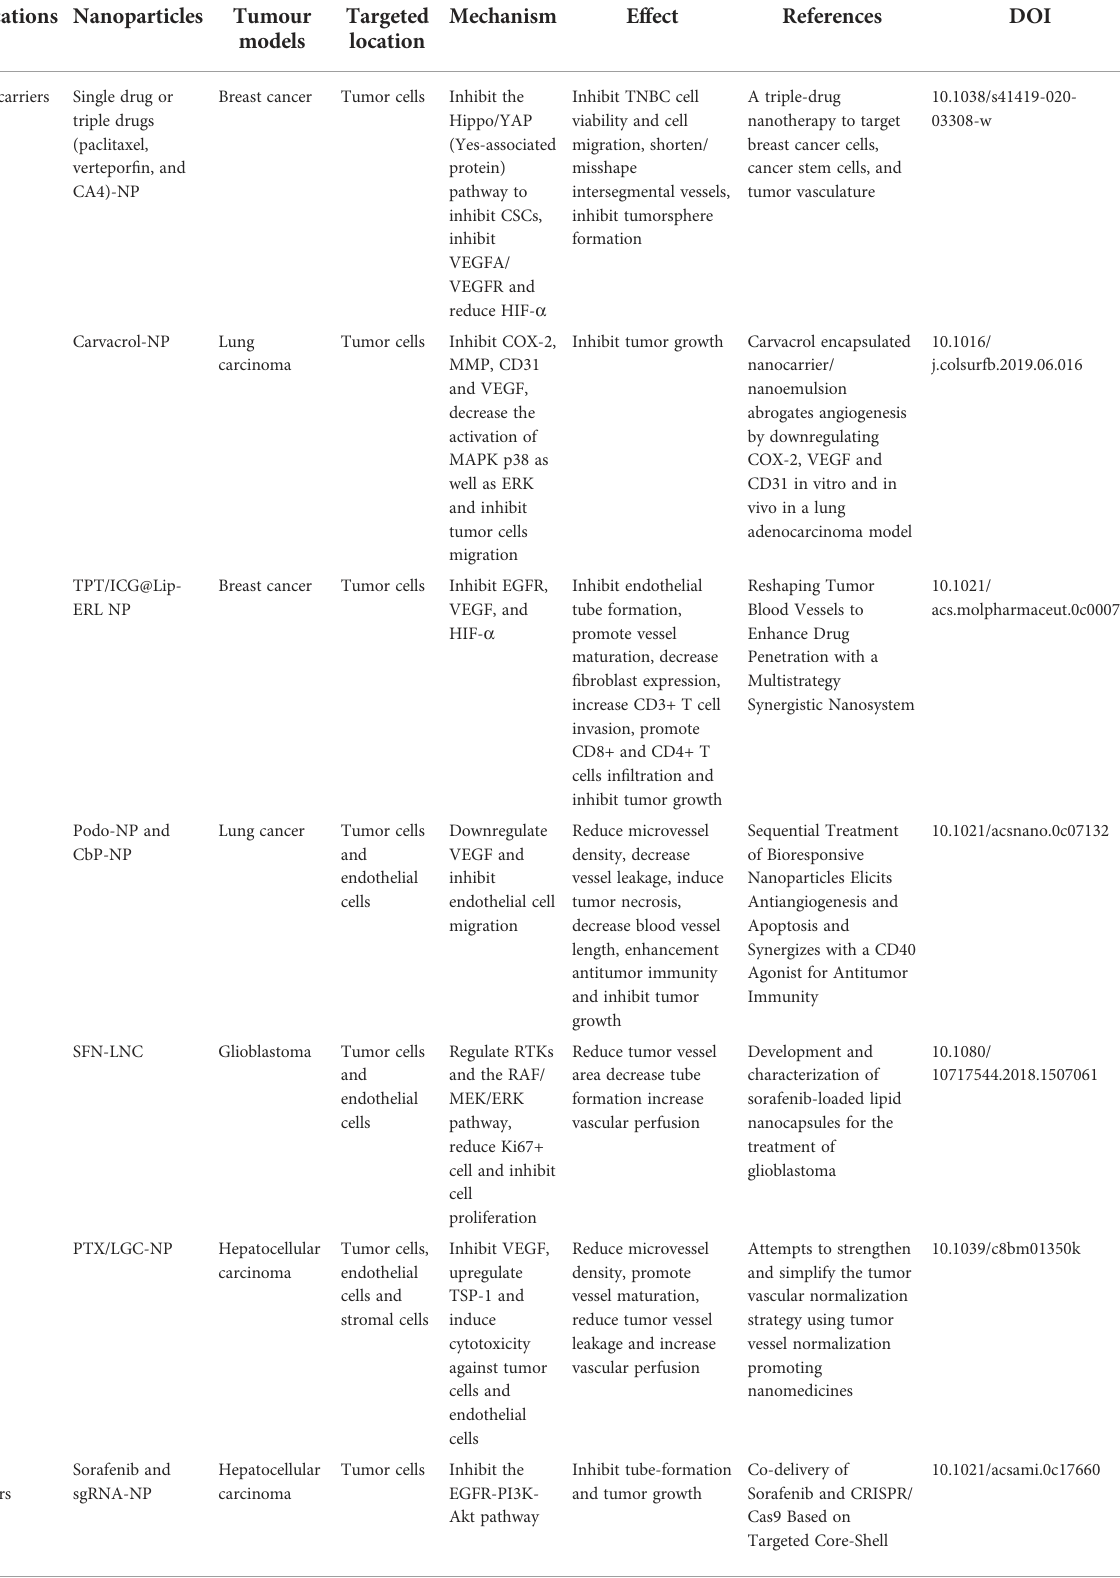
TABLE 2 Mechanisms and targets of nanomaterial-based anti-angiogenic